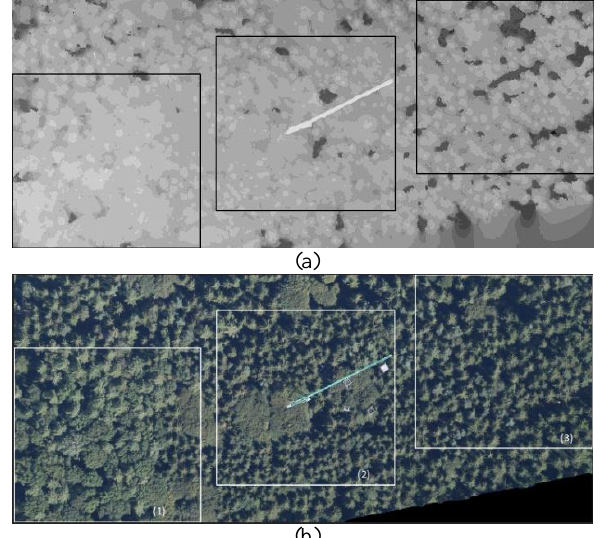
Figure 2. The DSM (a) and orthophoto (b) over Kranzberg